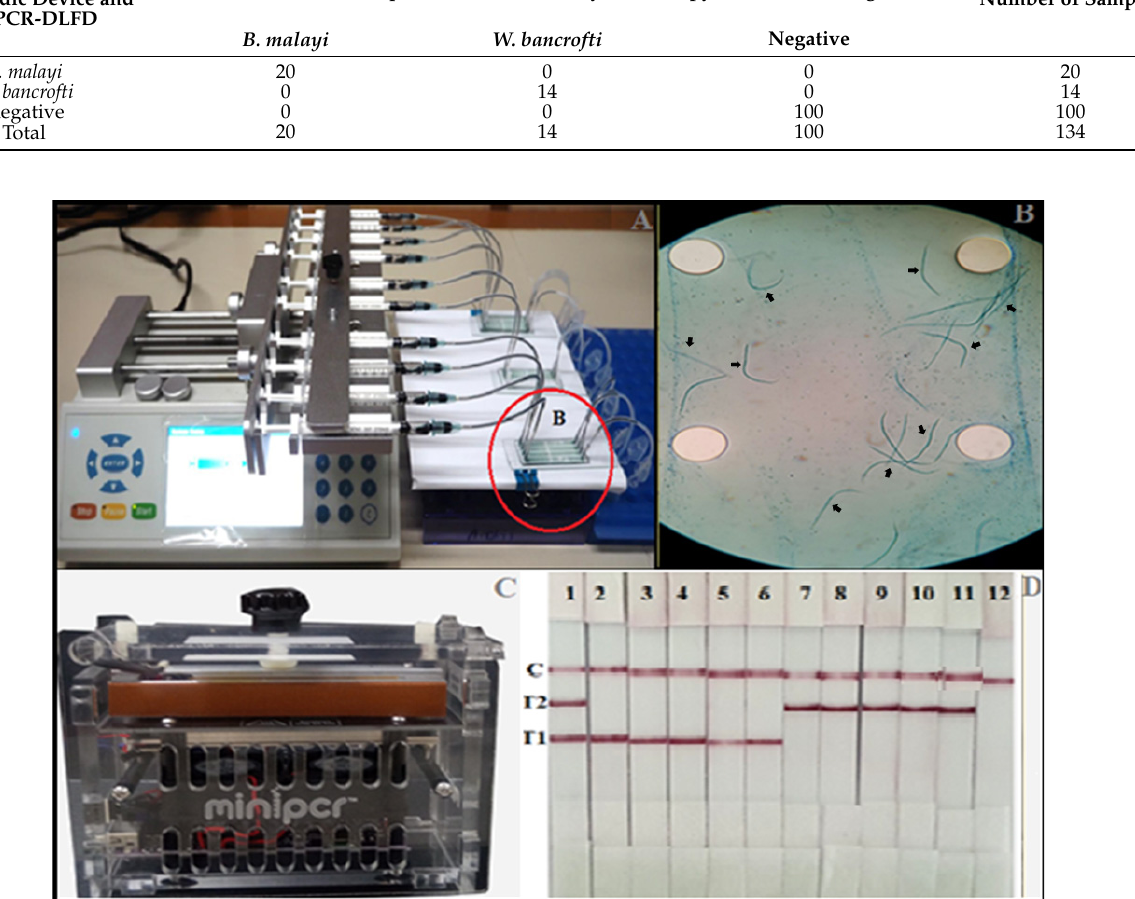
Figure 3. Microfluidic device coupled with the miniPCR-DLFD for rapid detection and identification of microfilariae of lymphatic filariae in human blood samples. ( A ) Microfluidic device. ( B ) Microfilariae trapped in the microfluidic chip (arrows). ( C ) The miniPCR thermocycler and ( D ) reaction of DLFD strips for species identification of the amplicon from trapped microfilariae (1 µL of each amplicon/strip). Strip 1: Positive control containing W. bancrofti and B. malayi DNA, strips 2–11: Representative of test samples, strip 12: Negative control. Table 1. Microfilaria detection and species identification in 134 human blood samples using the microfluidic device-iminiPCR-DLFD platform and microscopy.